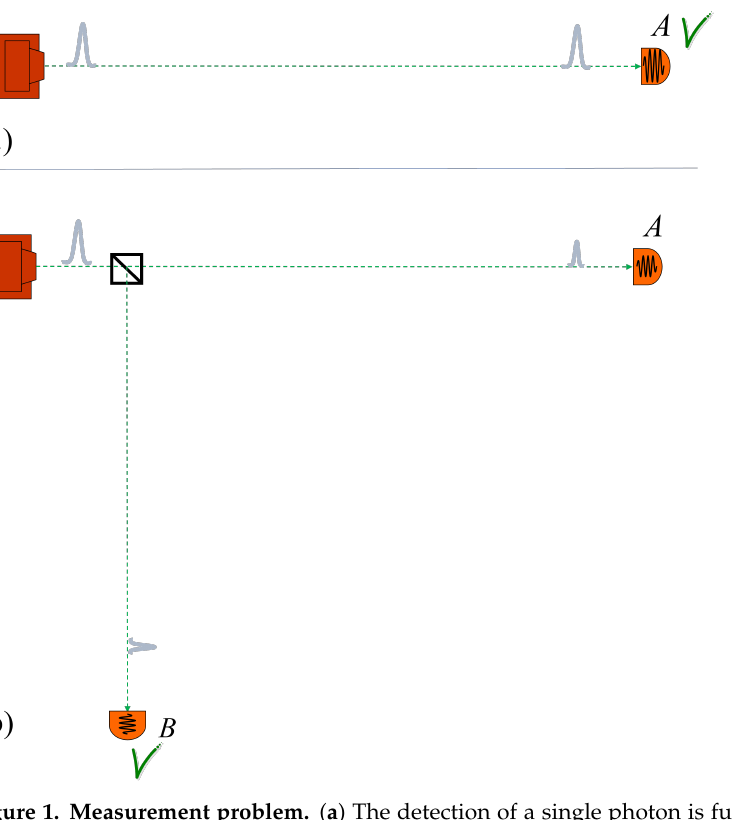
Figure 1. Measurement problem. ( a ) The detection of a single photon is fully understood by the creation of a particular quantum wave of parts of the single-photon detector. ( b ) In the experiment with a single-photon source, beamsplitter, and two detectors, the quantum mechanical equations show a similar (although reduced) change in two detectors. Nevertheless, we never observe simultaneous clicks of the two